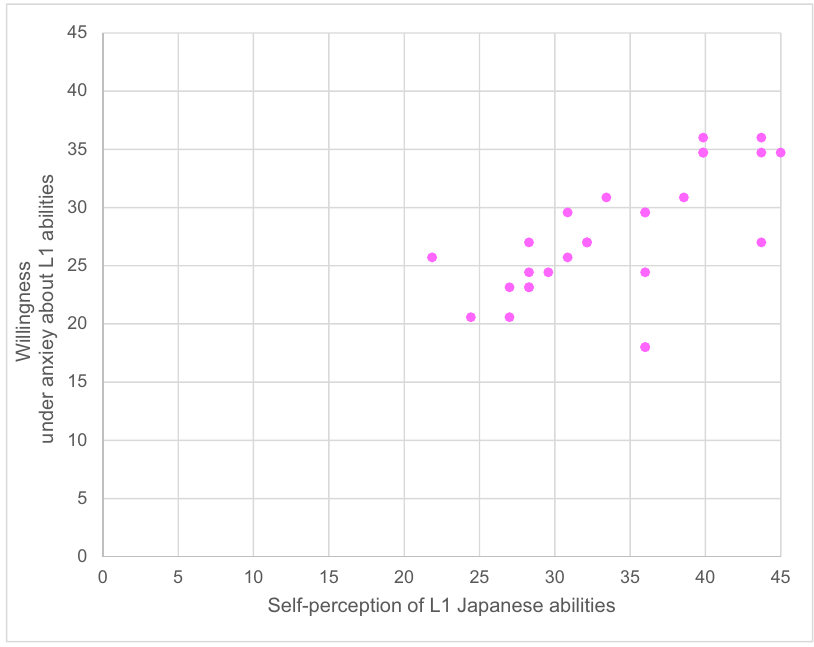
Figure 6: Correlation between willingness under anxiety about L1 abilities and self - perception of L1 abilities ( Likert points ) .